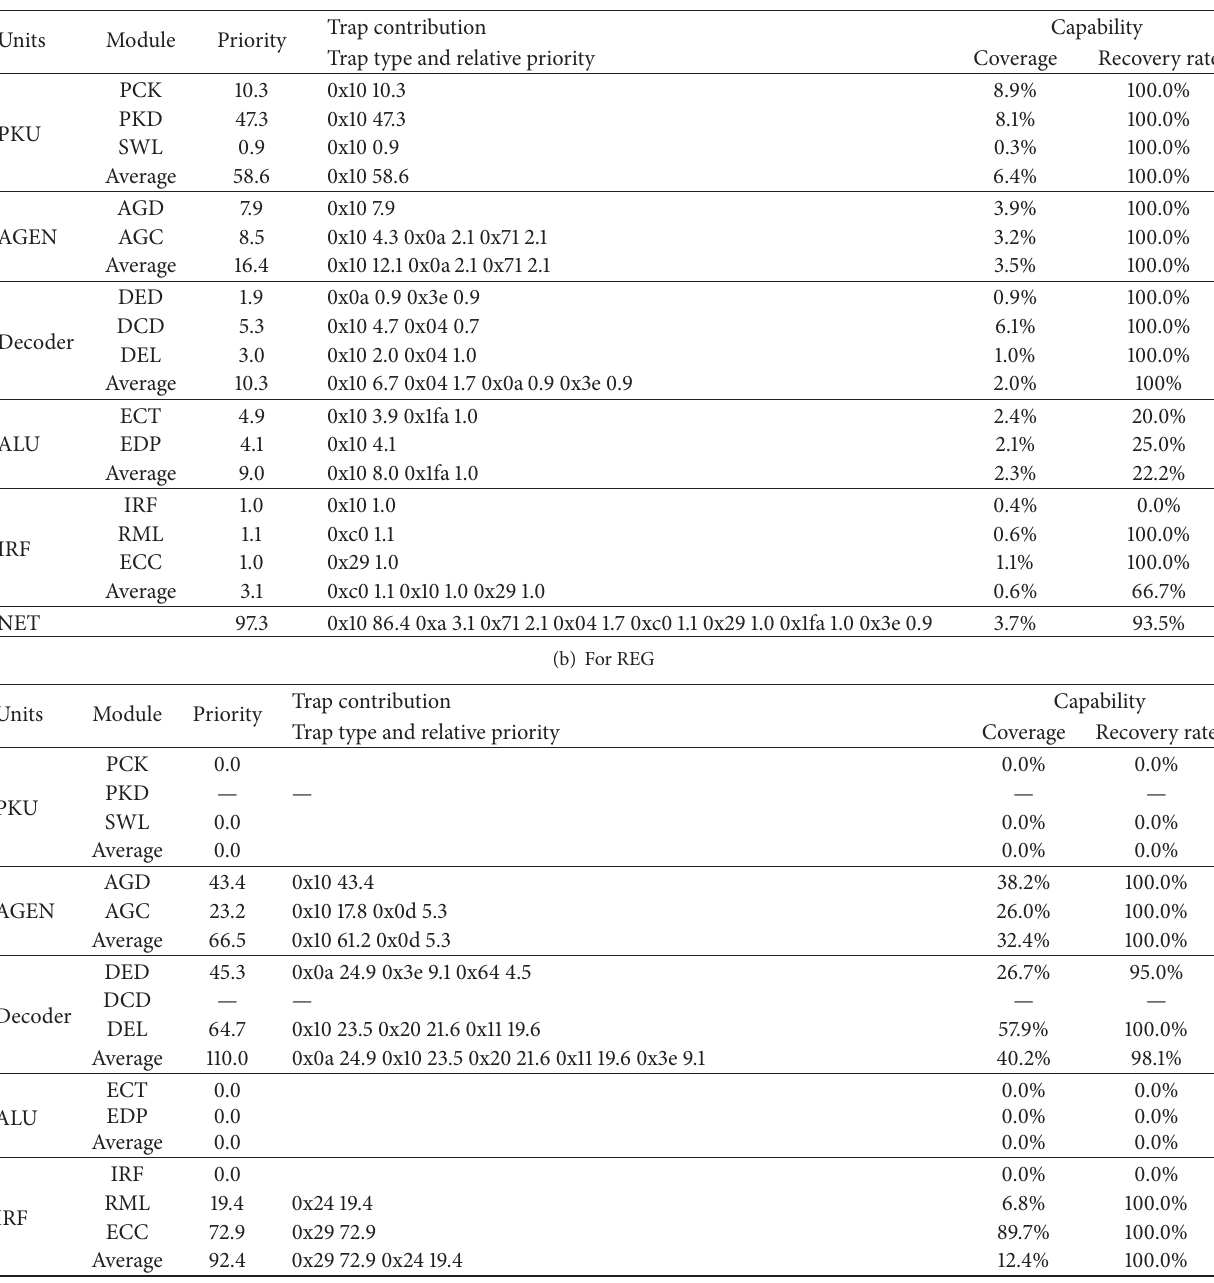
Table 12: Protect effects breakup per trap